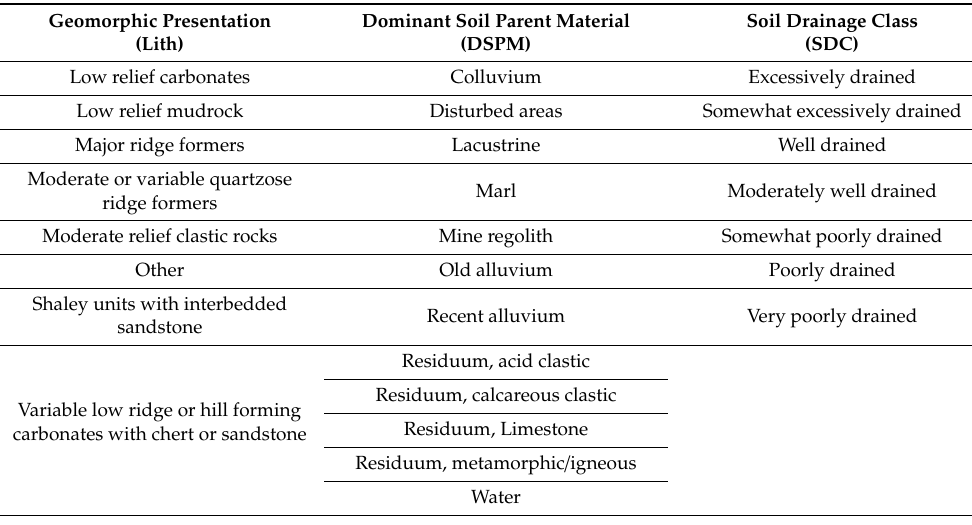
Table 4. Defined classes for lithologic and soil predictor